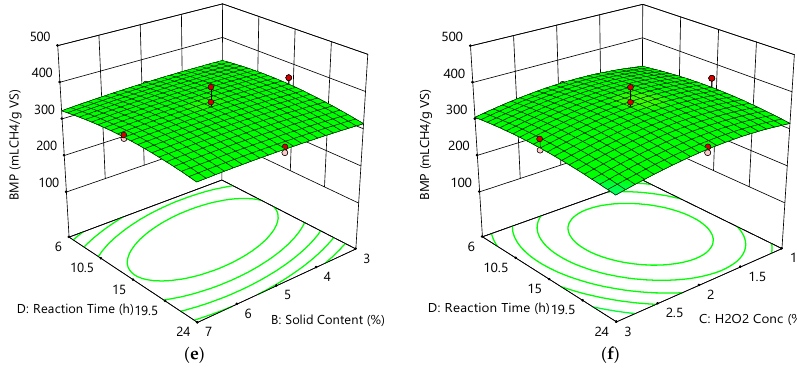
Figure 5. Effects of independent variables on biochemical methane potential (BMP). ( a ) H 2 O 2 concentration and temperature; ( b ) reaction time and temperature; ( c ) solid content and temperature; ( d ) H 2 O 2 concentration and solid content; ( e ) reaction time and solid content; ( f ) reaction time and H 2 O 2 concentration.